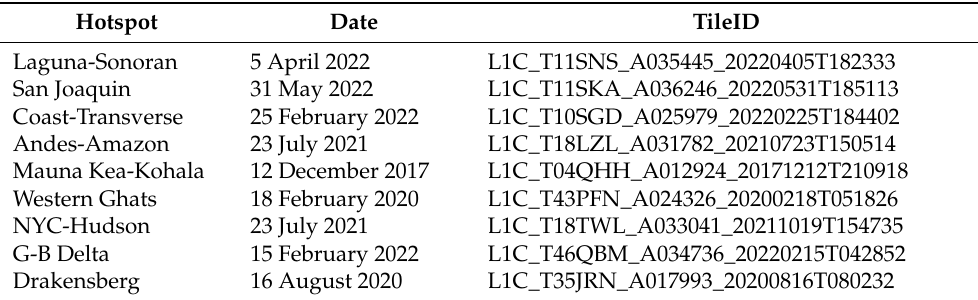
Table 1. Sentinel 2 metadata for the spectral diversity